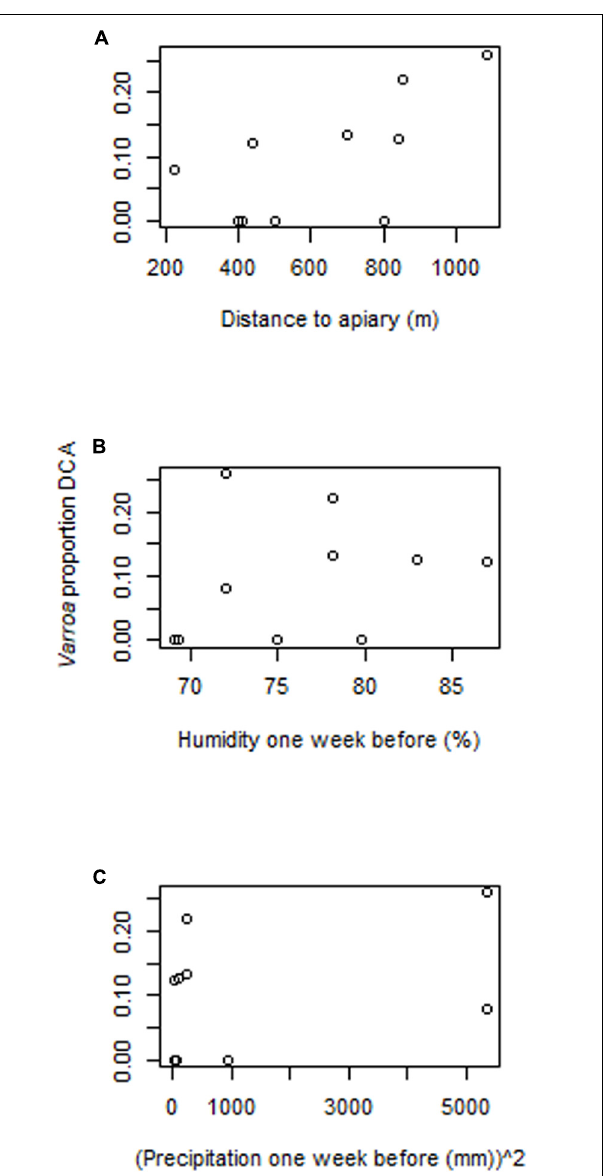
FIGURE 5 | Relationships between the proportion of Varroa in males at the Drone Congregation Areas and the environmental variables identified by the automatic Generalized Linear Model backward selection in R . (A) Distance from the DCA to the closest apiary, (B) humidity 1 week before Varroa estimation, and (C) precipitation 1 week before Varroa estimation. Proportion of Varroa infestation was arcsine-square root-transformed.